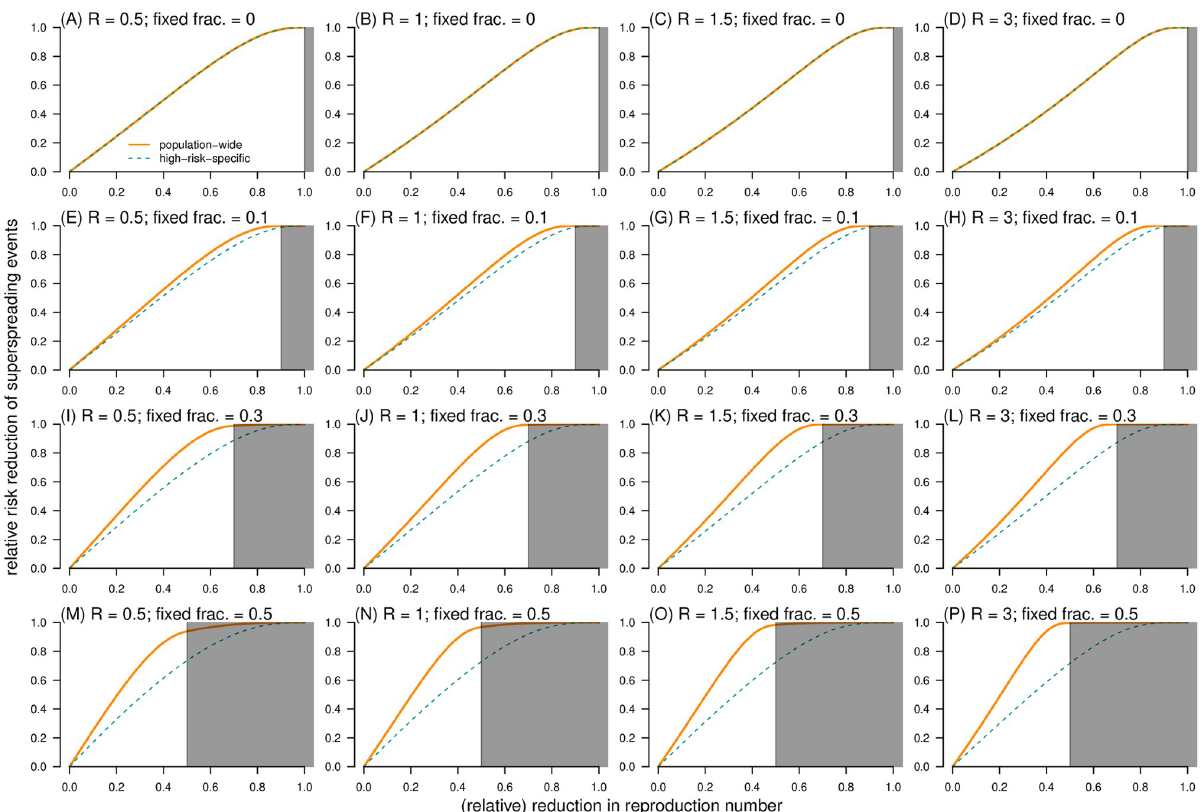
Fig 7. The relative risk reduction (RRR) of outcome (I): Having superspreading event as a function of the relative reduction in reproduction number ( ξ ). The RRR of control scheme ( I ) RRR (1) ( ξ ) is dashed cyan curve, and the RRR of control scheme ( II ) RRR (2) ( ξ ) is bold orange curve. In each panel, the dispersion parameter k is fixed at 0.2, and the shading region indicates the situation that ξ � 1 − ρ . In each panel label, ‘ R ’ is the reproduction number, and ‘fixed frac.’ is the fraction of fixed component ( ρ ).